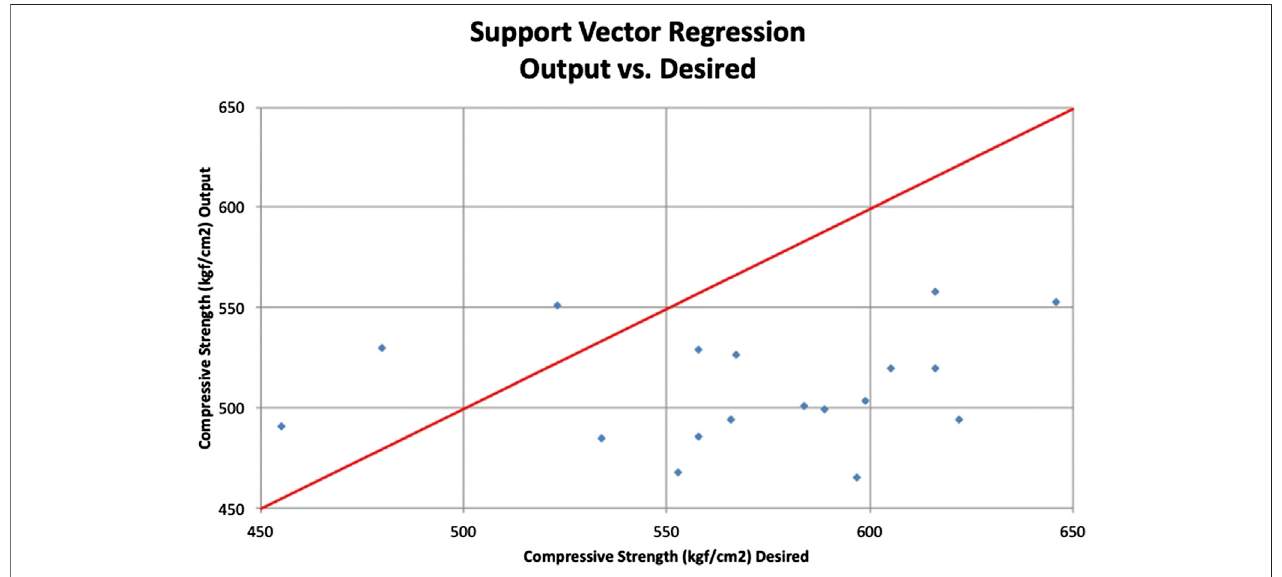
FIGURE 13 | Support vector regression model scatterplot